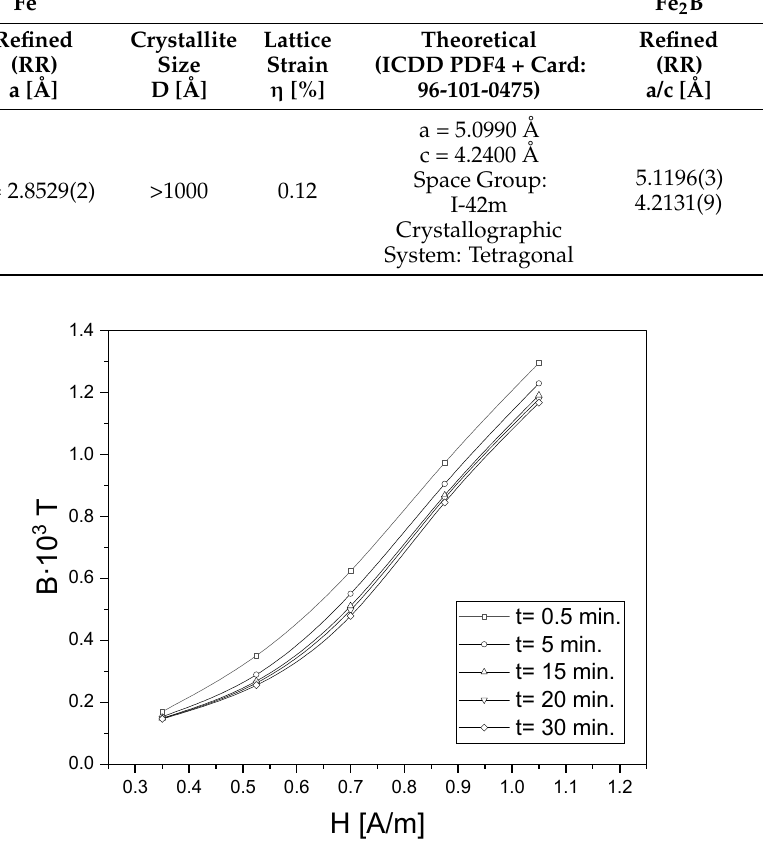
Figure 4. Isochronous curves B ( H , t ) for ti = const (counted from the moment of demagnetization) for the Fe 78 Si 13 B 9 sample.